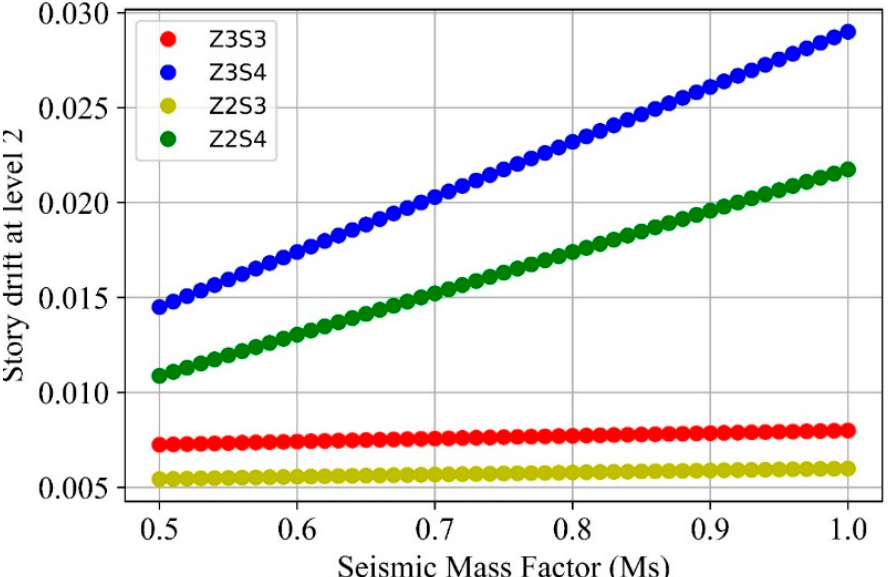
Figure 17. Variation of seismic mass factor (Ms) vs. drift at level 2.